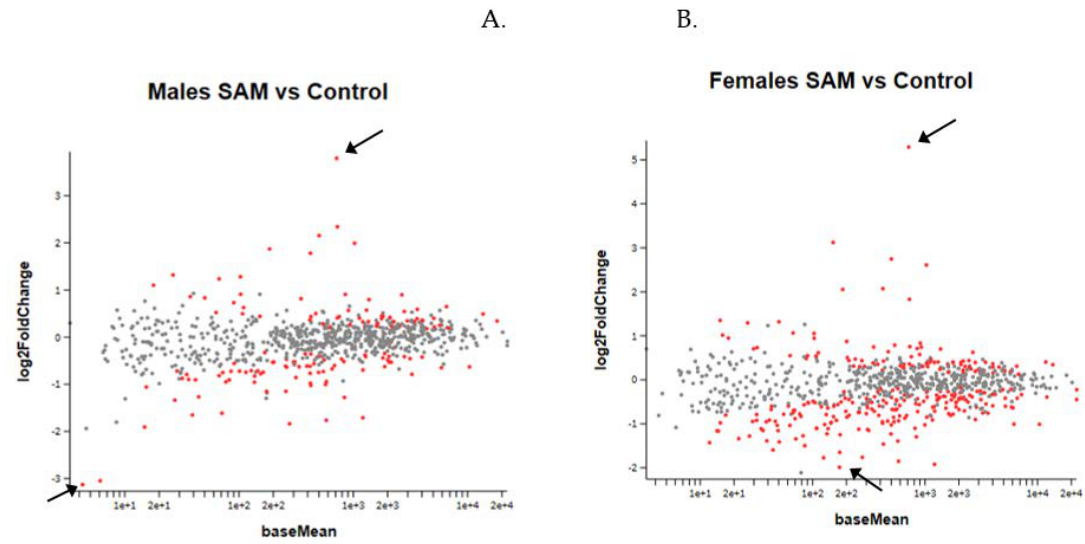
Figure 5. MA Plot of log 2 fold-change ( y -axis) versus base mean (normalized average expression ( x -axis). Every dot represents one gene. Red dots: genes with a statistically significant change compared to controls. Grey dots: no significant change. Higher and lower 2-fold change red dots are marked by arrows. ( A ). Gene expression in males. ( B ). Gene expression in females.